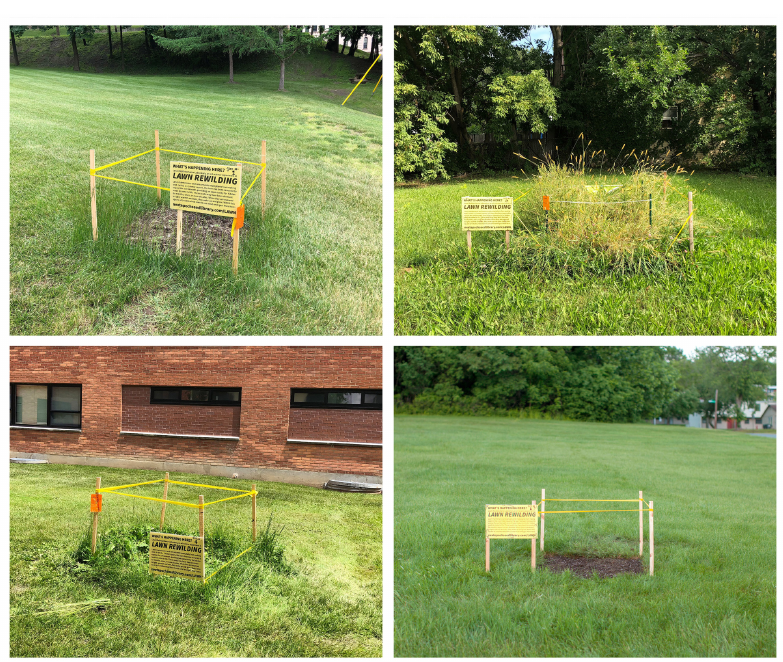
Figure 10: Lawn (Re)Disturbance Laboratory plots, summer 2018. Counterclockwise from top left: plot 1 (Rensselaer Polytechnic Institute, Sage Avenue and 9th Street); plot 4 (Rensselaer Polytechnic Institute, Nason dormitory lawn); plot 5 (Rensselaer Polytechnic Institute, Detroit Avenue and Georgian Terrace); plot 8 (privately owned lot, North Central Troy, Ingalls Avenue and River